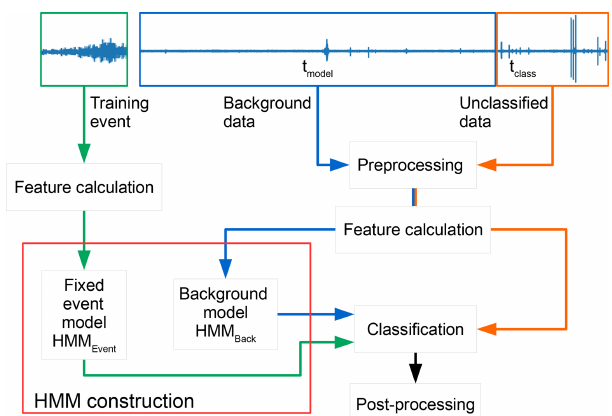
Figure 4. Flow chart of the classification process. Green lines show the construction of the event model, blue lines show the construction of the background model and orange lines show how the data to be classified are